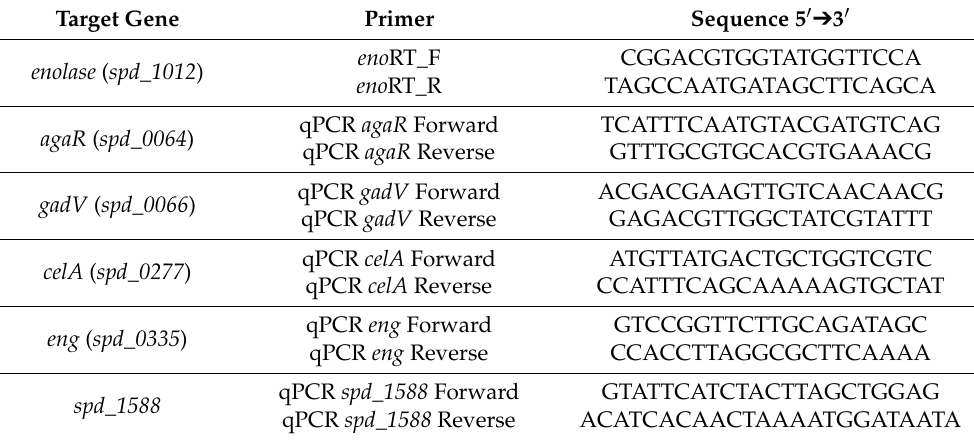
Table 4. Primers used for